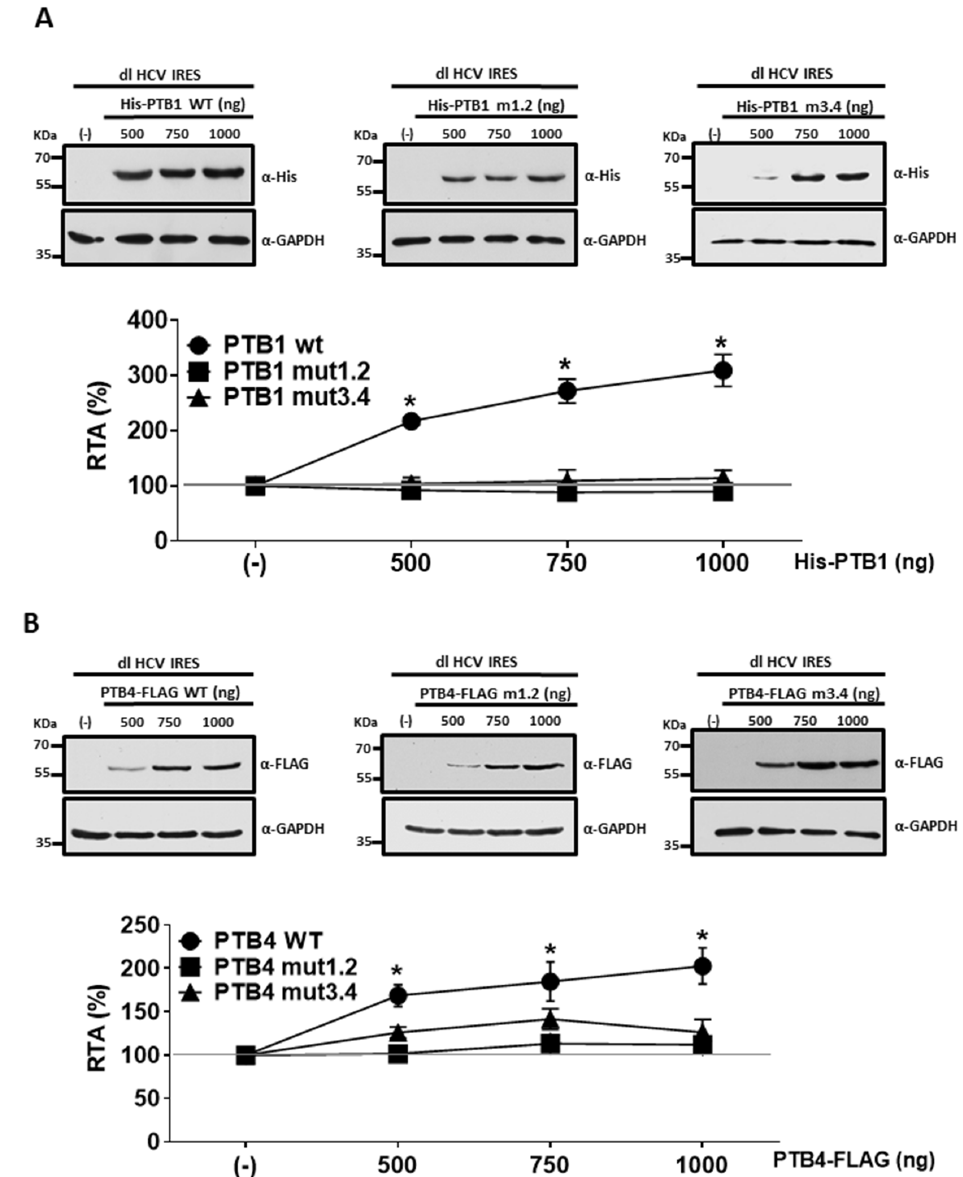
Figure 5. PTB1 and PTB4 require RRM1/RRM2 and RRM3/RRM4 to stimulate HCV IRES activity in HuH ‐ 7 cells. ( A , B ) HuH ‐ 7 cells were transfected with the dl HCV IRES plasmid (100 ng) together with the pcDNA3.1 ‐ LacZ (25 ng), and a vector expressing His ‐ tagged versions of PTB1(wt), PTB1mut1.2, or PTB1mut3.4 or a FLAG ‐ tagged version of PTB4(wt), PTB4mut1.2, or PTB4mut3.4. The pSP64 ‐ Poly(A) vector was used as a control ( ‐ ). Expression of the tagged proteins was confirmed by Western blotting using an anti ‐ His ( α His) ( A ) or anti ‐ FLAG ( α FLAG) ( B ) antibody. GAPDH was detected using an anti ‐ GAPDH antibody ( α GAPDH) as a loading control. Luciferase activities were measured and expressed as RTA(%) relative to the activity measured in the HuH ‐ 7 cells transfected with dl HCV IRES, pcDNA3.1 ‐ LacZ, and pSP64 ‐ Poly(A). Results for PTB1 and its mutants are shown in ( A ), and PTB4 and its mutants are shown in ( B ). Values are the means (±SEM) from three independent experiments. Statistical analysis was undertaken by the ANOVA test, followed by Dunnett’s multiple comparisons tests; * p < 0.05 vs. the negative control.